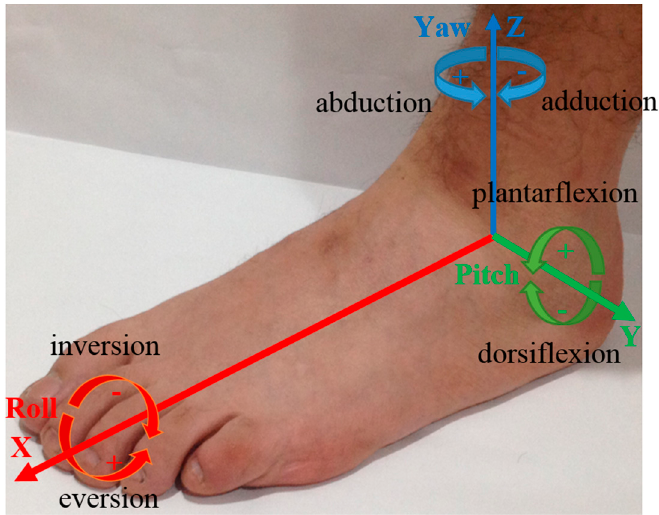
Figure 1. Foot anatomical reference frame, and the six basic movements: abduction, adduction, plantarflexion, dorsiflexion, inversion, and eversion. Sign of the rotation is specified according to the mathematical definition of the counterclockwise (positive) or clockwise (negative) rotation.